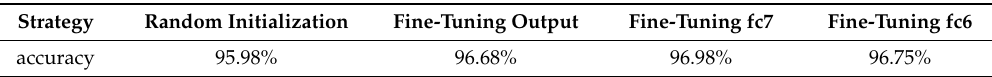
Table 3. Testing accuracy of well-training models.